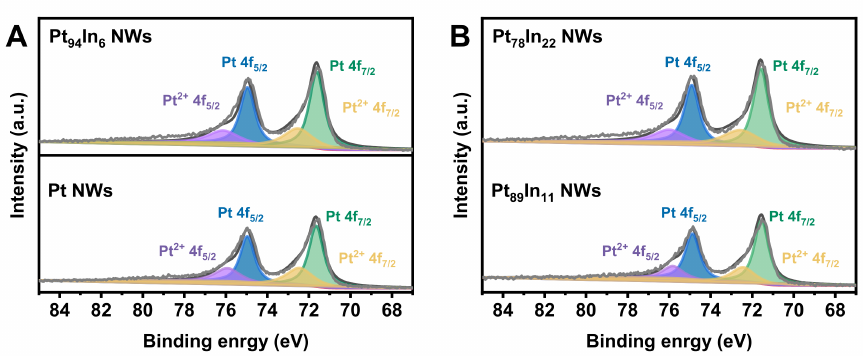
Figure 3. High-resolution Pt 4 f XPS spectra of ( A ) Pt 96 In 6 NWs and Pt, ( B ) Pt 78 In 22 NWs and Pt 89 In 11